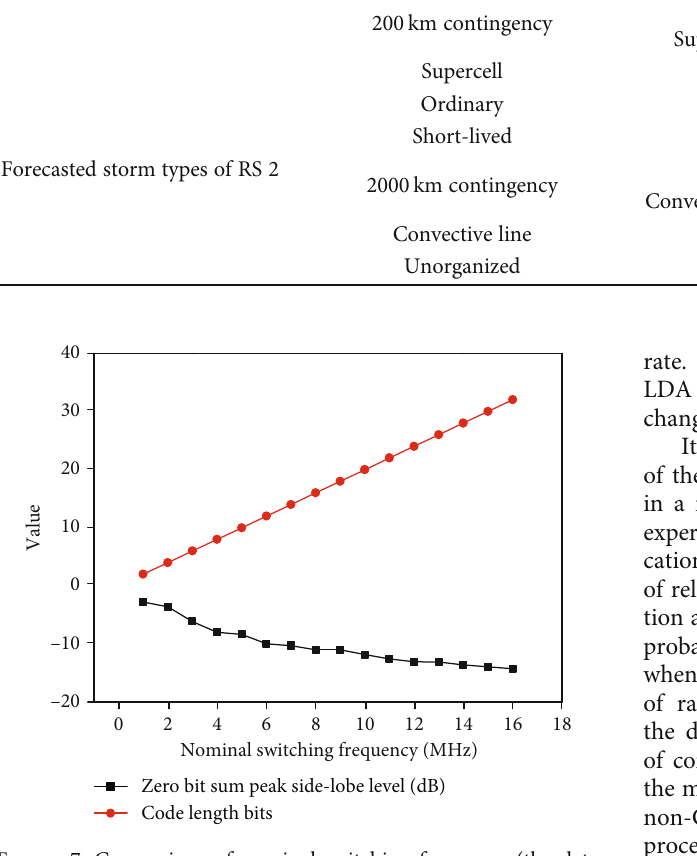
Figure 7: Comparison of nominal switching frequency (the data were obtained from Ref.